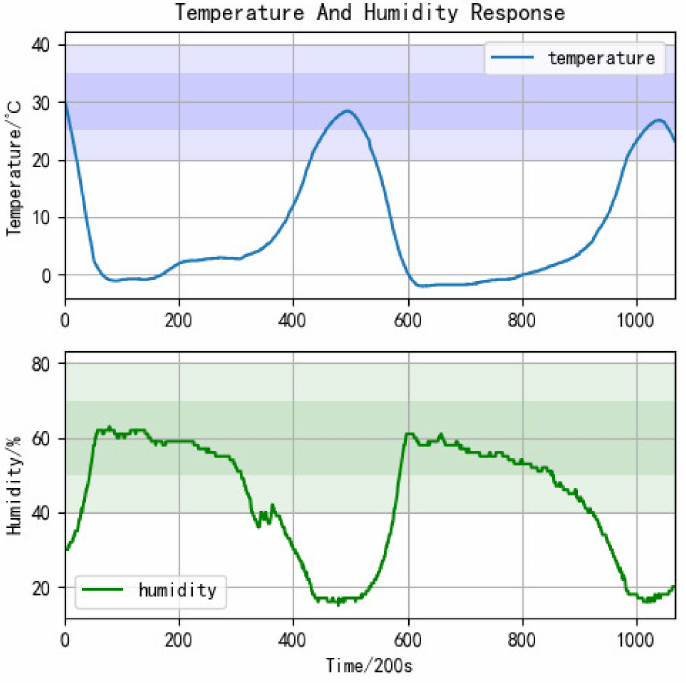
Figure 17. Greenhouse temperature and humidity data simulating the general greenhouse scene. Substituting the above data, Figure 18 can be obtained. Figure 18 is divided into three parts from top to bottom: temperature, humidity curve, and corresponding controller status. The dark color part in the background of the curve denotes the optimal growth interval of the crop, while the light color denotes the normal growth interval of the